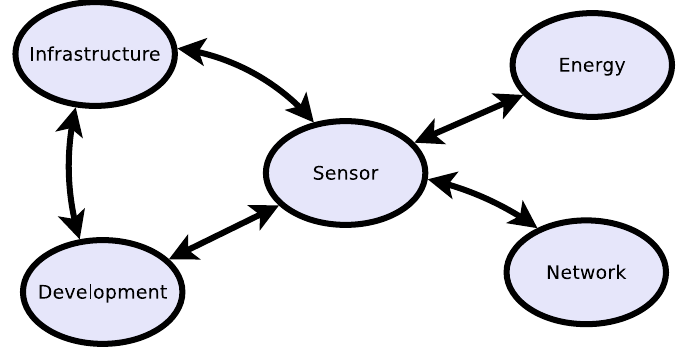
Figure 1. Cost components and their